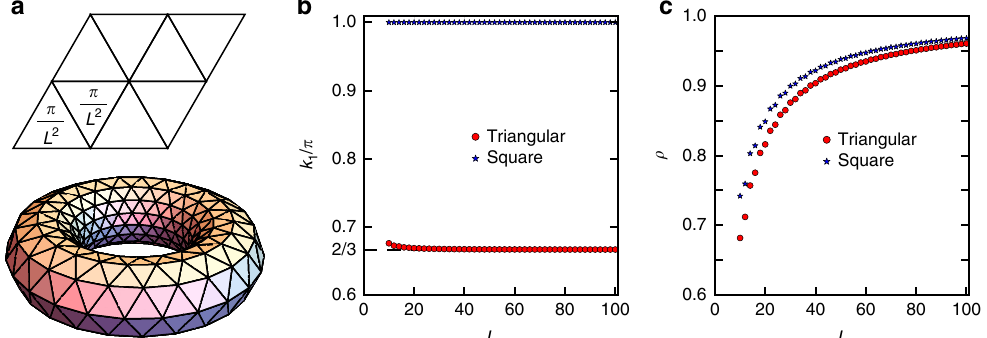
Fig. 5 Numerical results of momentum of the monopoles. a We wrap the system on a L × L torus, and uniformly spread 2 π / L 2 fl ux in each unit cell. b , c To extract the lattice momentum, we calculate h ψ j G T (cid:8) T 1 j ψ i ¼ ρ e ik 1 , and fi nd k 1 = 2 π /3 on the triangular lattice and k 1 = π on the square lattice. ρ is close to 1 1 for a large system size, which indicates that the translation symmetry is approximately